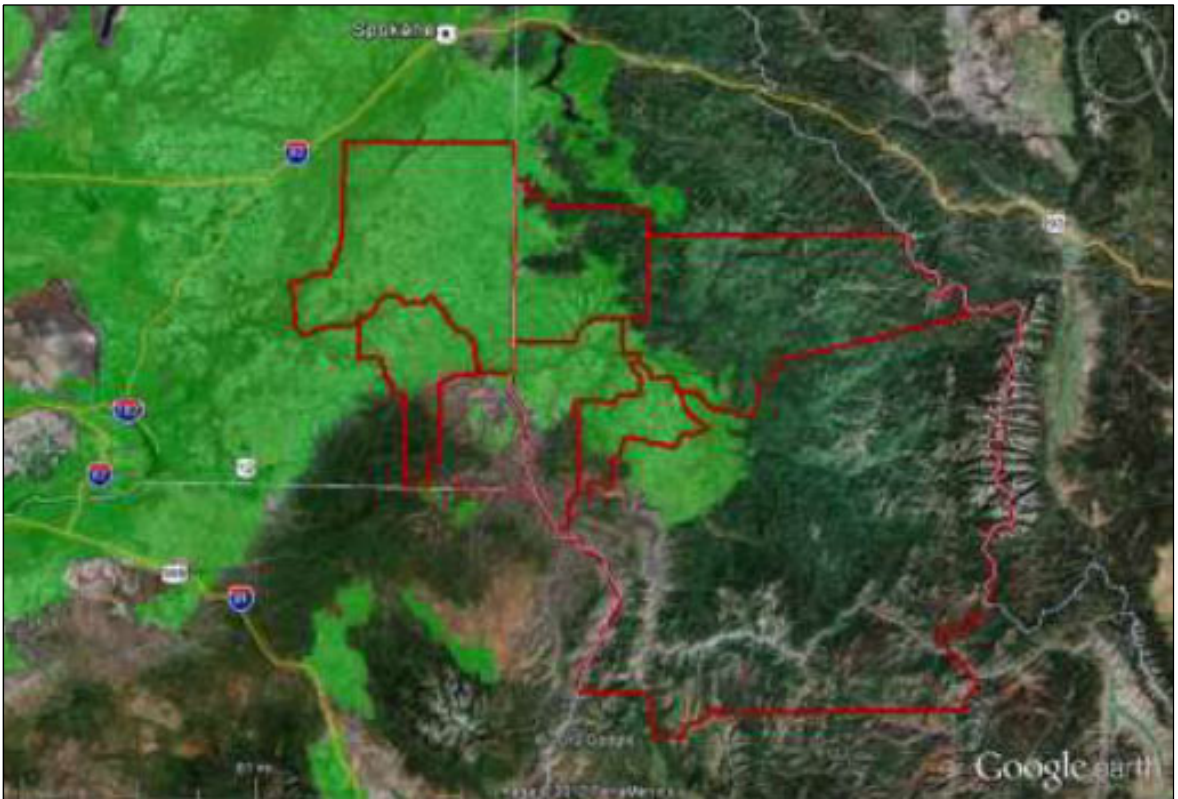
Source: Earth (Manheim Solutions, Inc. & Watson Regional Economic Network,